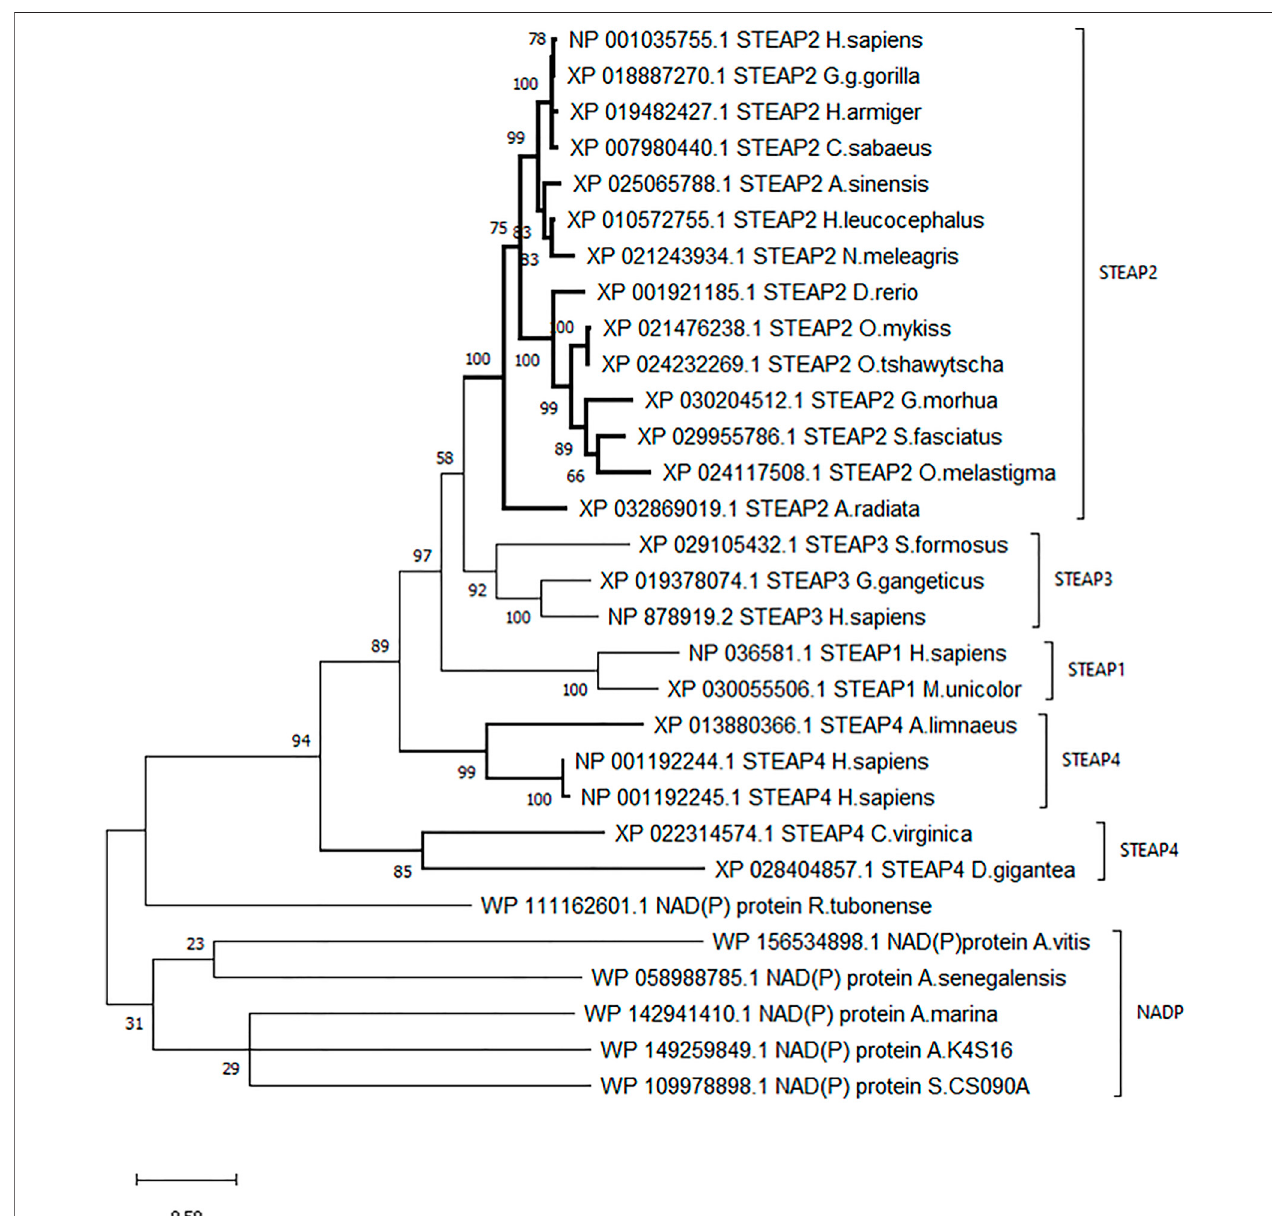
FIGURE3| Phylogenetictreeof H.sapiens STEAP2showsthatitismostrelatedto G.gorilla sinceitisredrawn78%of1,000timesbythebootstrapmethod.This, therefore, indicates that these species ’ have the most conserved